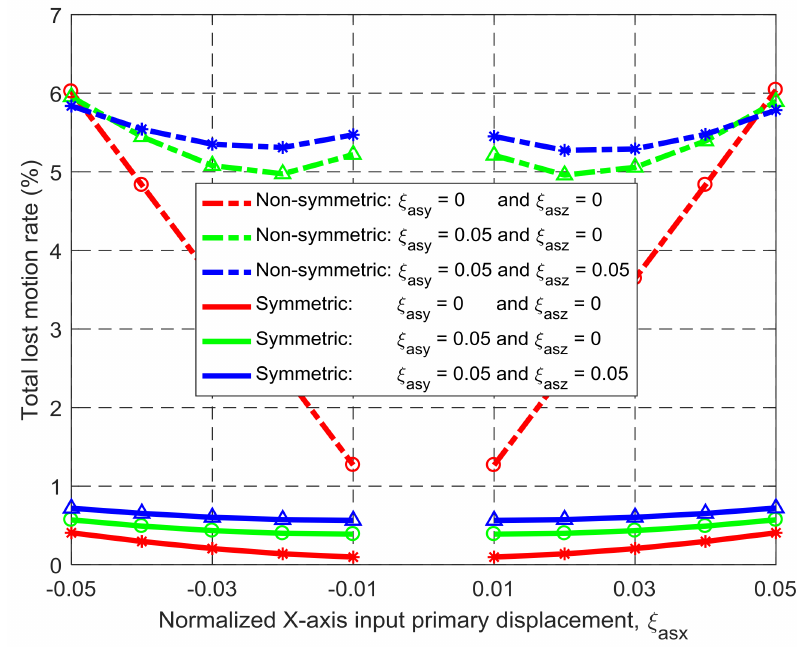
Figure 8. Comparison of lost motions between the symmetric and non-symmetric XYZ CPMs shown in Figure 3a,h (Symbols, ‘*’, ‘ (cid:52) ’ and ‘ ’, in this figure are data points). (cid:35)